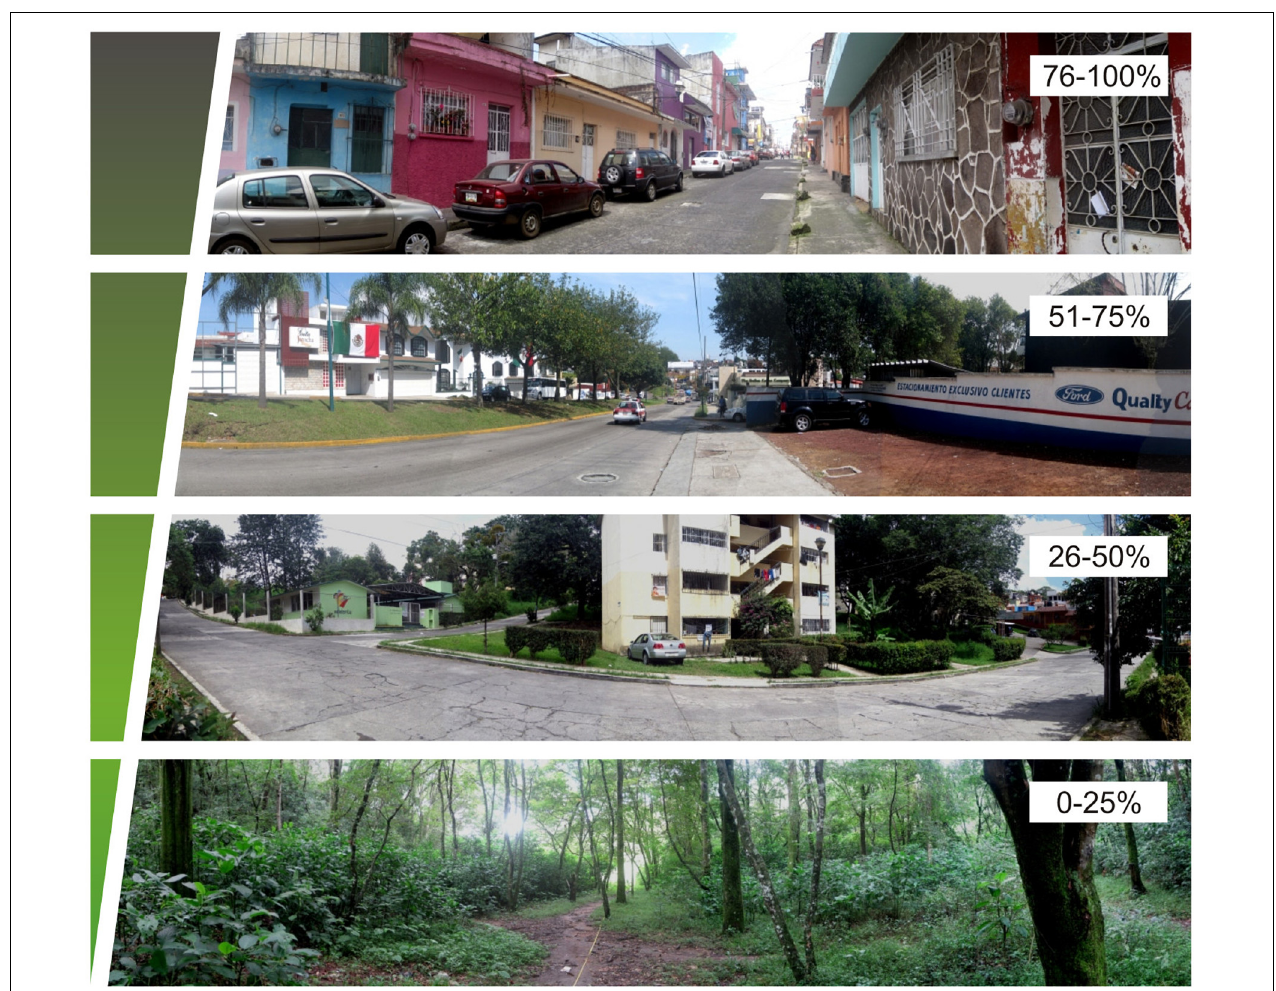
FIGURE 2 | Depiction of the surveyed urbanization density classes. Class I = 0–25% built cover, Class II = 26–50% built cover, Class III = 51–75% built cover, Class IV = 76–100% built cover. Photo credit: Ina